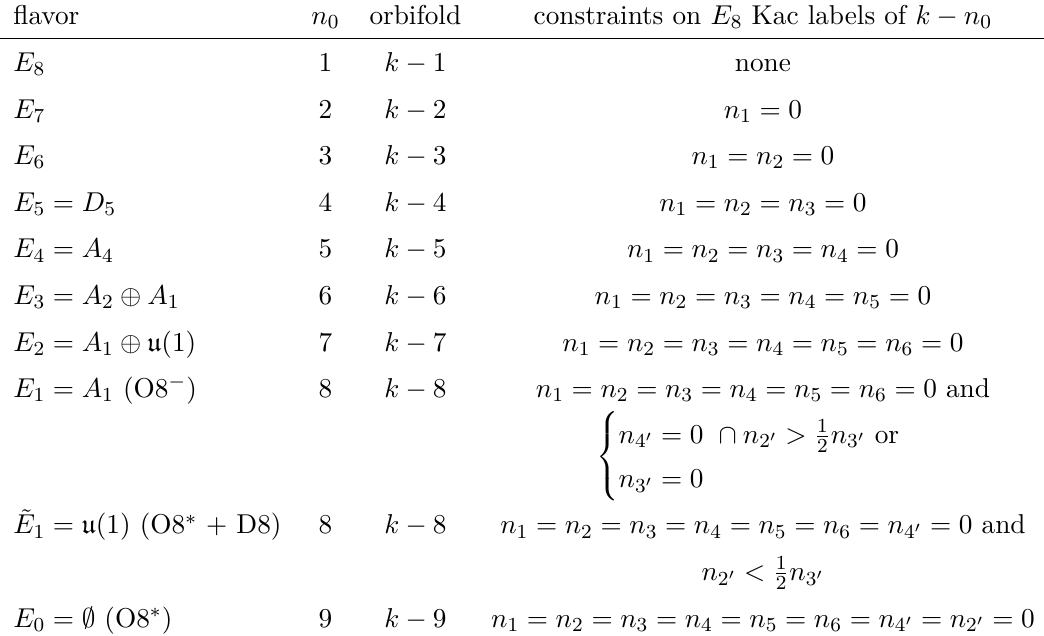
Table 1. Constrained E 8 Kac labels of k − n 0 identifying massive E semi-infinite D6’s. In the n not constrained, k and N are, since k = Nn not. Satisfactorily, the conditions for ˜ E since the former theory in 5d flows to the latter via mass deformation